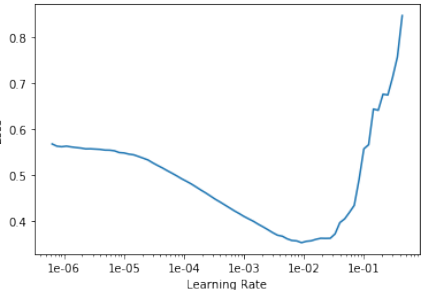
Figure 10. Plot of the loss along iterations of the learning rate finder. An appropriate learning rate would fall between 1 × 10 − 3 and 5 × 10 − 2 .